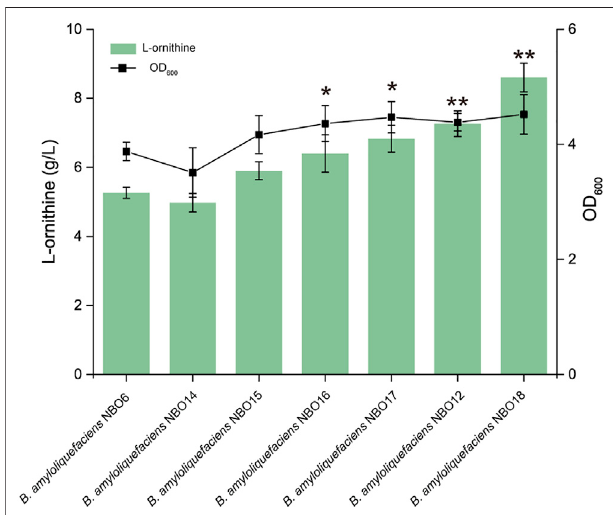
FIGURE 3 | The expression of lysE increases L -ornithine synthesis and cell growth. The effect of the overexpression of four transporter genes on L -ornithine production and cell growth. Four L -ornithine transporters from different sources were screened, namely, E. coli , C. glutamicum , B. subtilis , and B. amyloliquefaciens . All data were the average of three independent studies with standard deviations. The ** and * indicate p < 0.01 and0.05relativetothecontrolstrain B.amyloliquefaciens